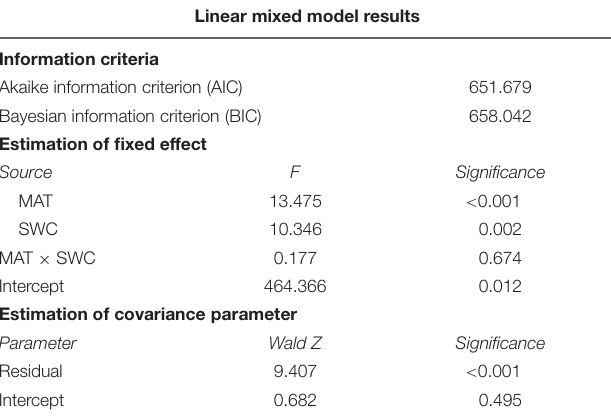
TABLE 5 | Summary of the linear mixed model of (cid:2) with MAT, SWC and their interaction (MAT × SWC) as the fixed variables while the sampling mountains as the random